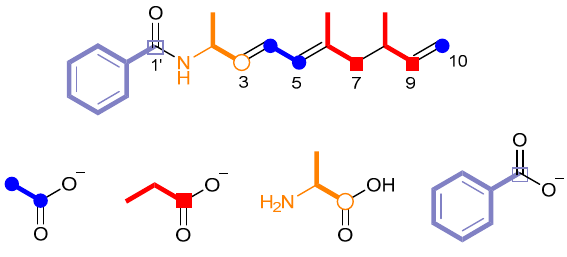
Figure 3. Biosynthetic building blocks of haliamide ( 1 ) deduced from feeding experiments.